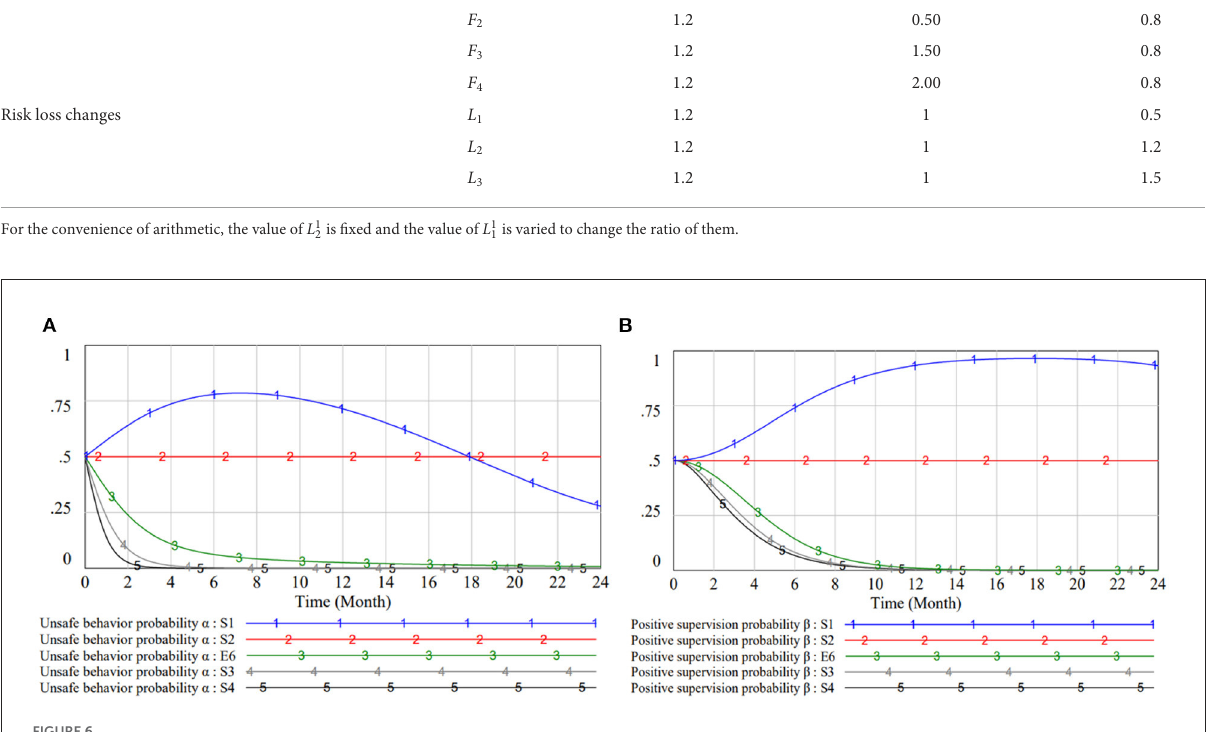
FIGURE6 Impact of S on subject strategies. (A) Impact of S on workers strategy selection in different scenarios. (B) Impact of S on managers strategy selection in different